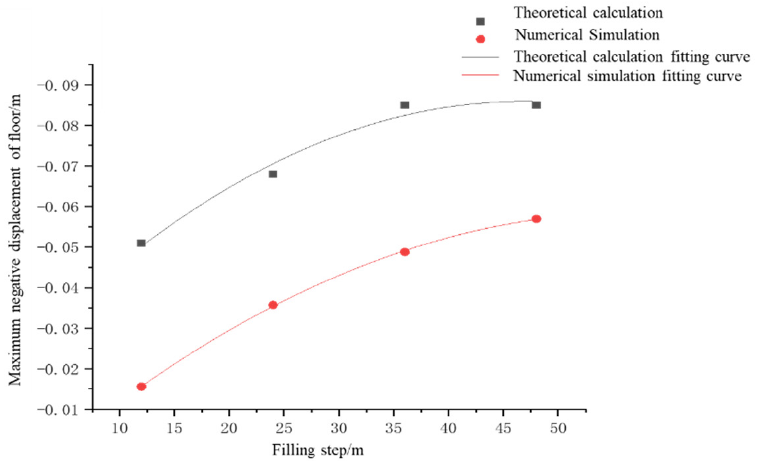
Figure 14. The relationship between different advancing distances and the maximum negative displacement of the floor.